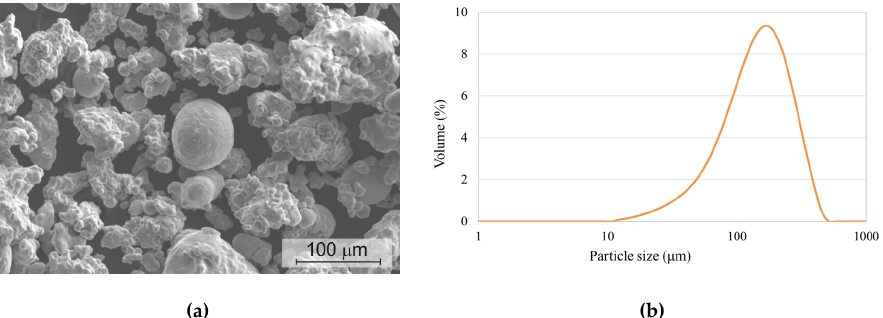
Figure 2. ( a ) SEM micrograph and ( b ) granulometric distribution of the Fe Atomet 1001HP powder used in the CDEC experiments.